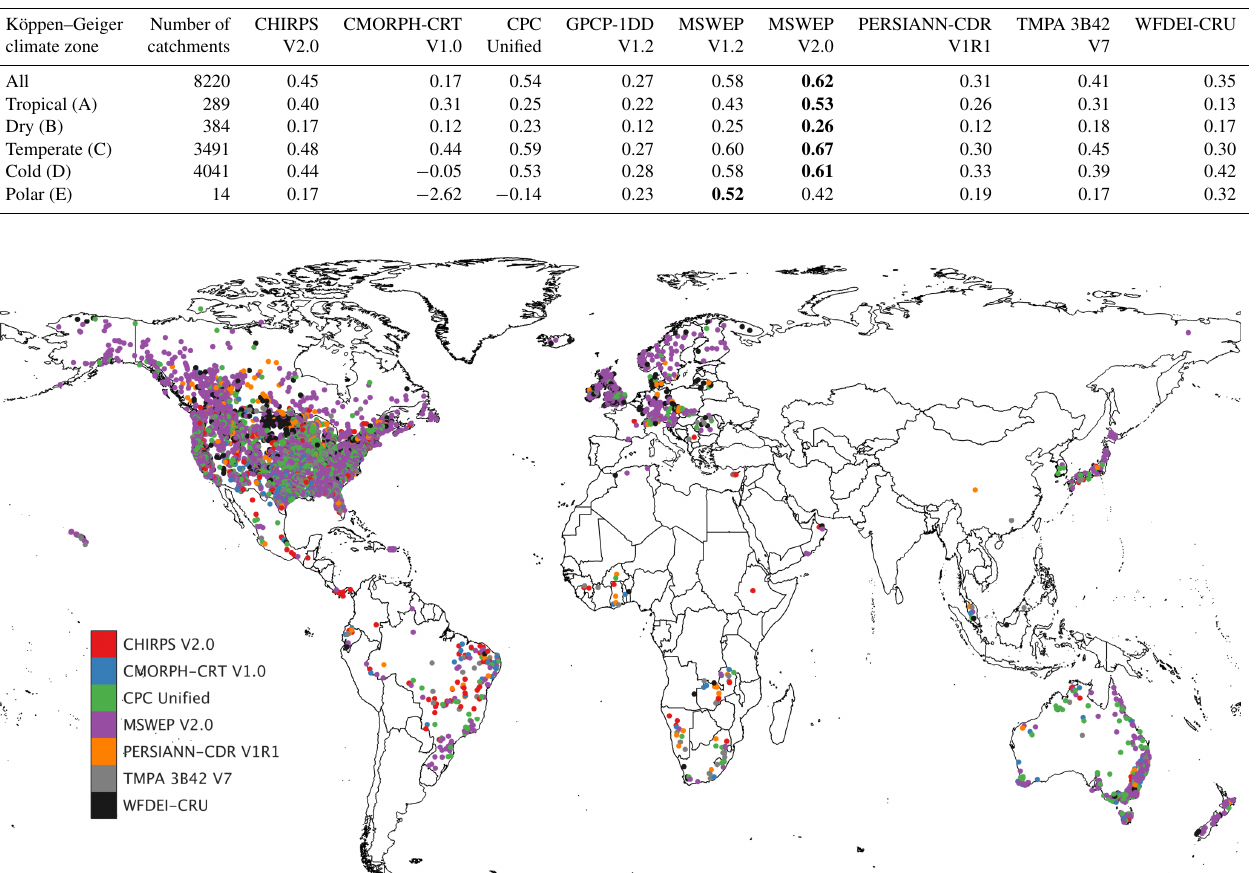
Figure 3. For each catchment, the P dataset with the highest calibration NSE. Each data point represents a catchment centroid. Only the seven best performing P datasets (excluding MSWEP V1.2 due to its similarity to V2.0) are considered. Note that CHIRPS V2.0, CMORPH- CRT V1.0, PERSIANN-CDR V1R1, and TMPA 3B42 V7 do not provide data beyond 50, 60, 60, and 50 ◦ latitude,